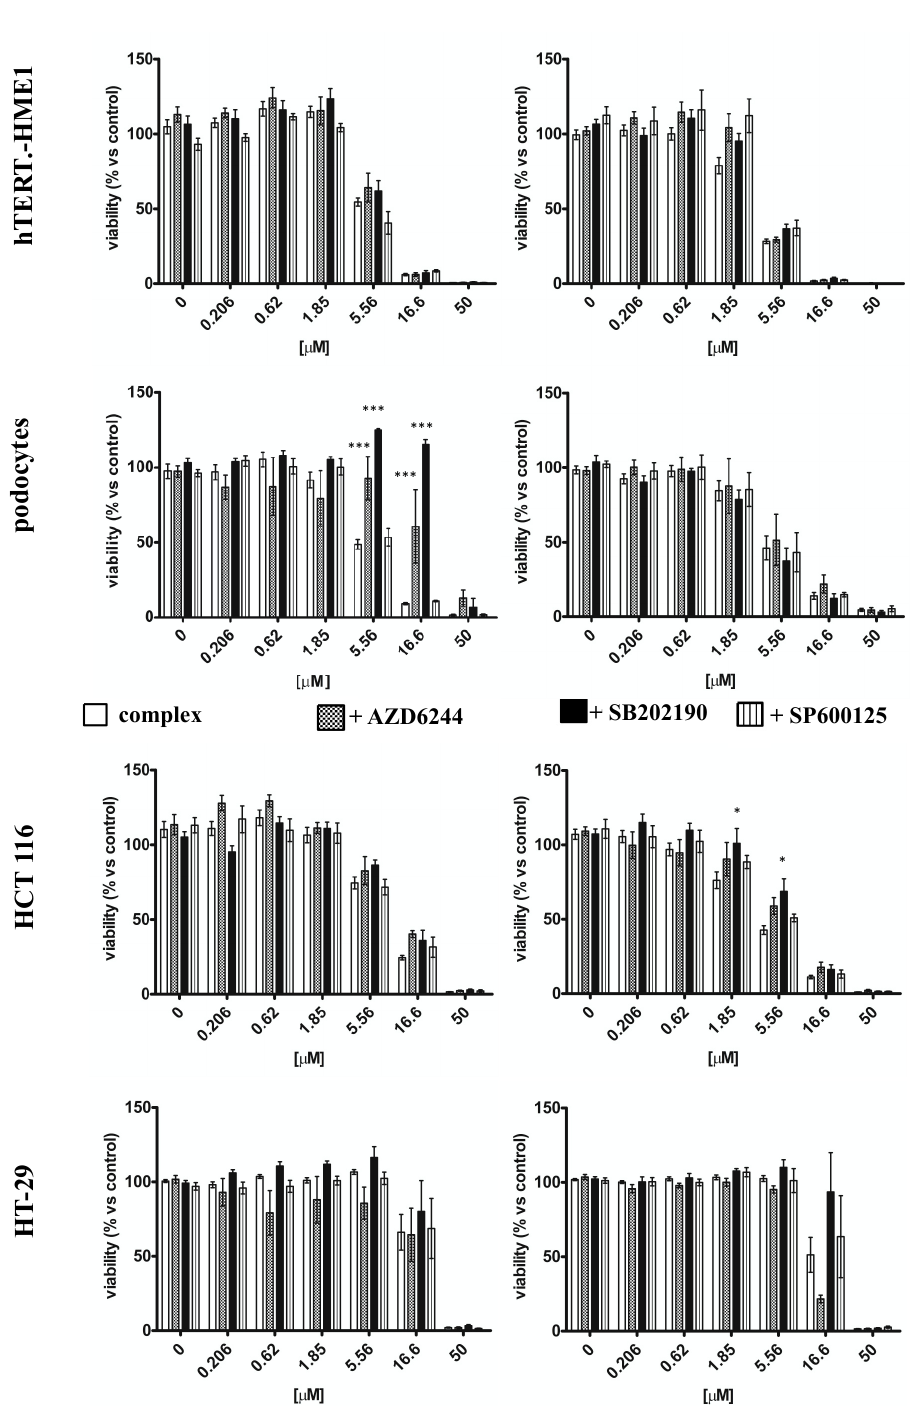
Figure 6. Effect of MAPKs inhibitors used in association with complex c and complex d. Cells were pre-treated with AZD6244, SB202190, or SP600125 (all 100 nM), inhibitors of p42/44, p38, and JNK, respectively, for 30 min; then cells were treated with complexes (0.206–50 µ M) for 6 days. Results are normalized to the growth of non-treated cells and are represented as mean ± standard error of mean (S.E.M.) of at least three independent experiments. * p < 0.05, *** p < 0.001 vs. complex